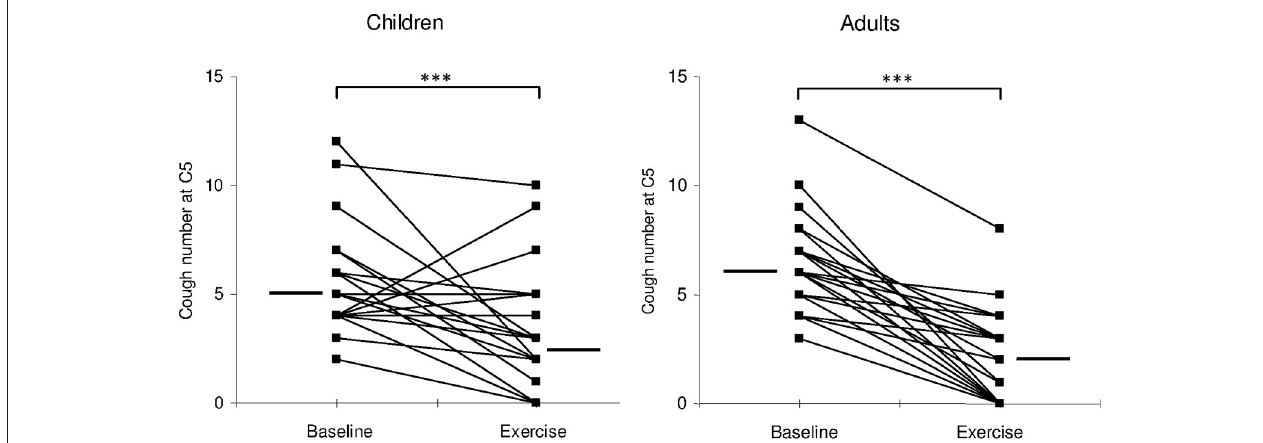
FIGURE 1 | Individual values (filed squares) and median values (thick lines) of cough number, provoked by C5 concentration of capsaicin, at rest (baseline) and during exercise (exercise). *** p < 0.0005.